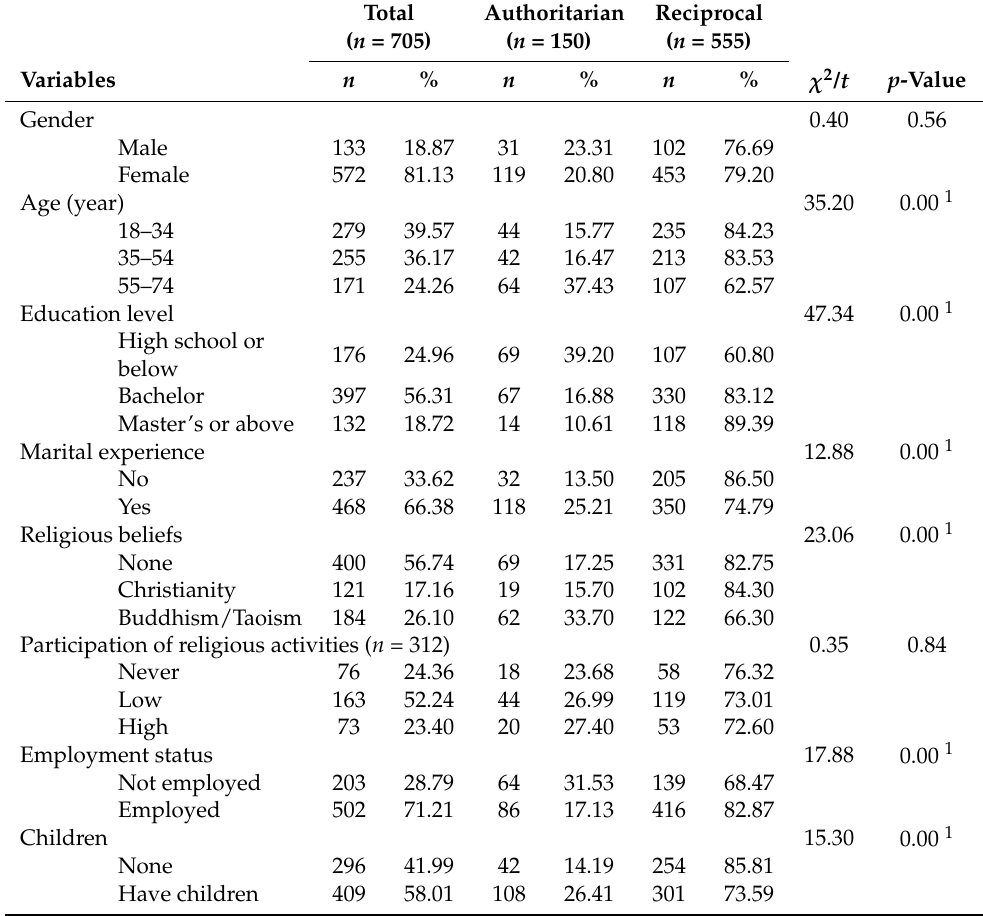
Table 1. Participant characteristics with correlation analyses to examine FPR differences ( n = 705).